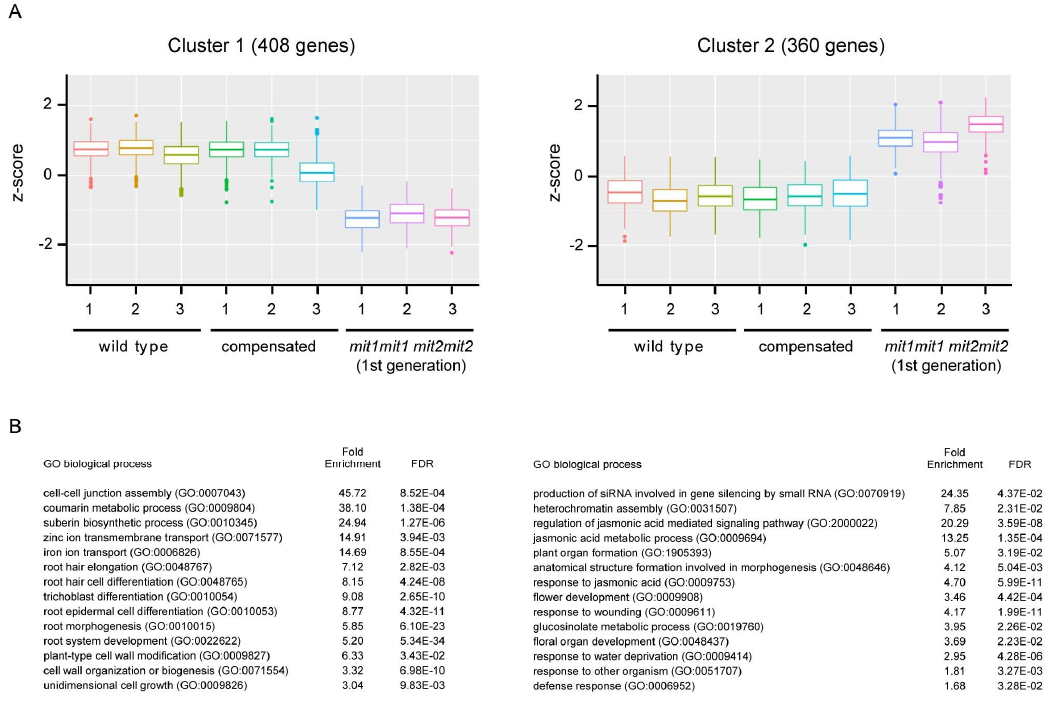
Figure 9. ( A ) K-means clustering of differentially expressed genes. RNAs were prepared from seedlings at the same developmental stage: wild type plants (18 days old), compensated double homozygous mutant plants (18 day old), and 1st generation of double homozygous mutant plants with an affected phenotype (27 day old). RNAseq was performed on three biological replicates (seedlings grown on different days) for each group. Differentially expressed genes (at least two ‐ fold) were identified using DEseq2 software and clustered by k ‐ means. ( B ) Some enriched GO terms (biological processes) in clusters 1 and 2. See Supplementary Tables S6 and S7 for more detailed information.